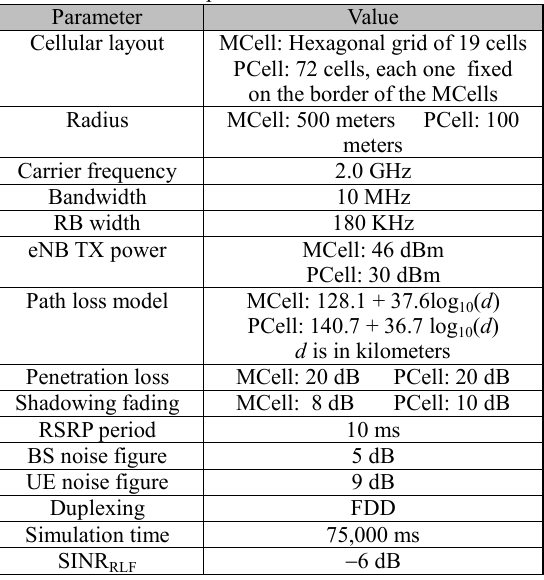
Fig. 8. The network employed for the simulation. Table 2. The parameters of the